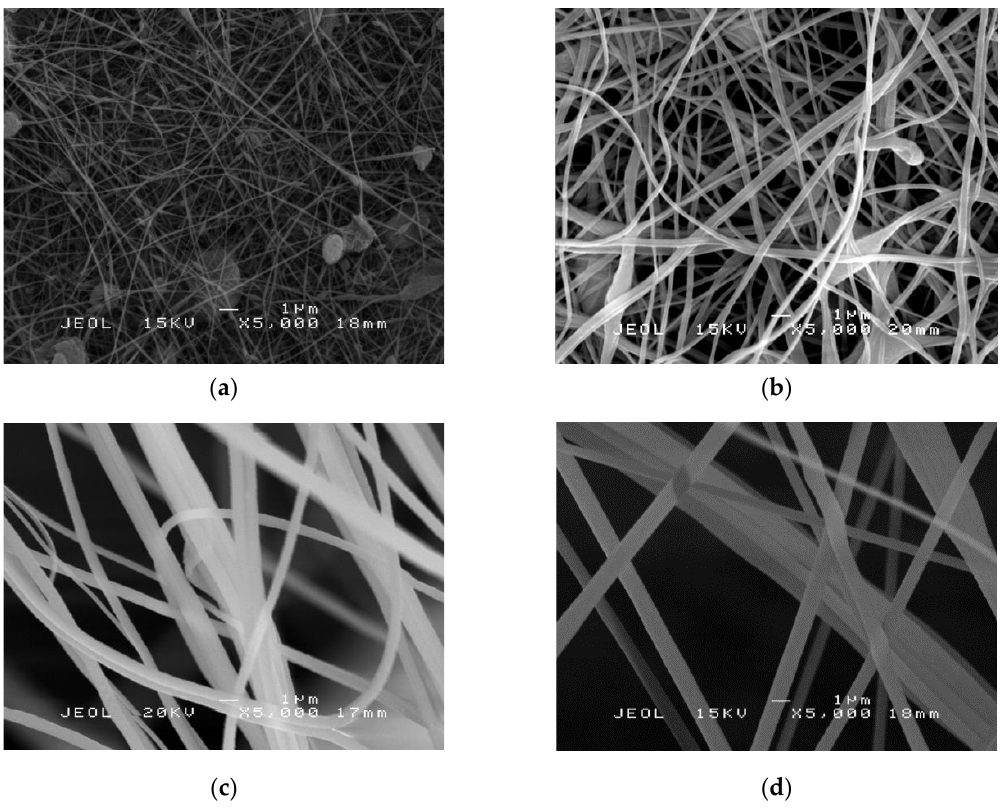
Figure 1. SEM micrographs of polyacylonitrile (PAN) nanofibers: ( a ) 2.5%, ( b ) 5% ( c ) 7.5% and ( d ) 10% of PAN solution (5000× magnifications).